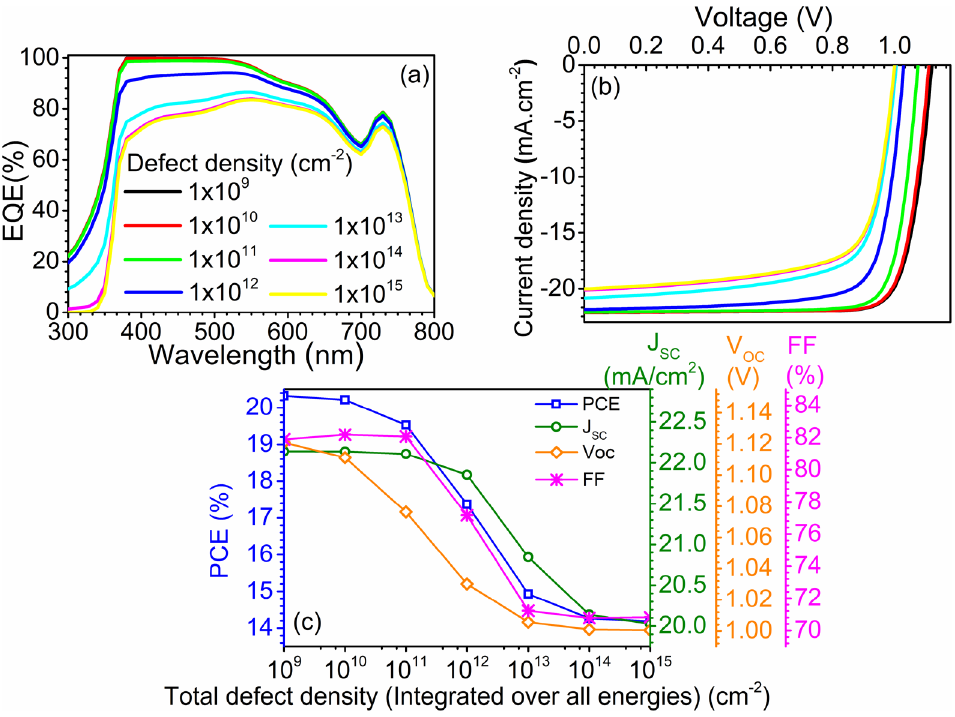
Figure 6. Impact of perovskite/ETL interface defect density (IDD) on ( a ) EQE, ( b ) illuminated J–V curve, and ( c ) PV parameters. Data reported in figures are obtained from the SCAPS-1D